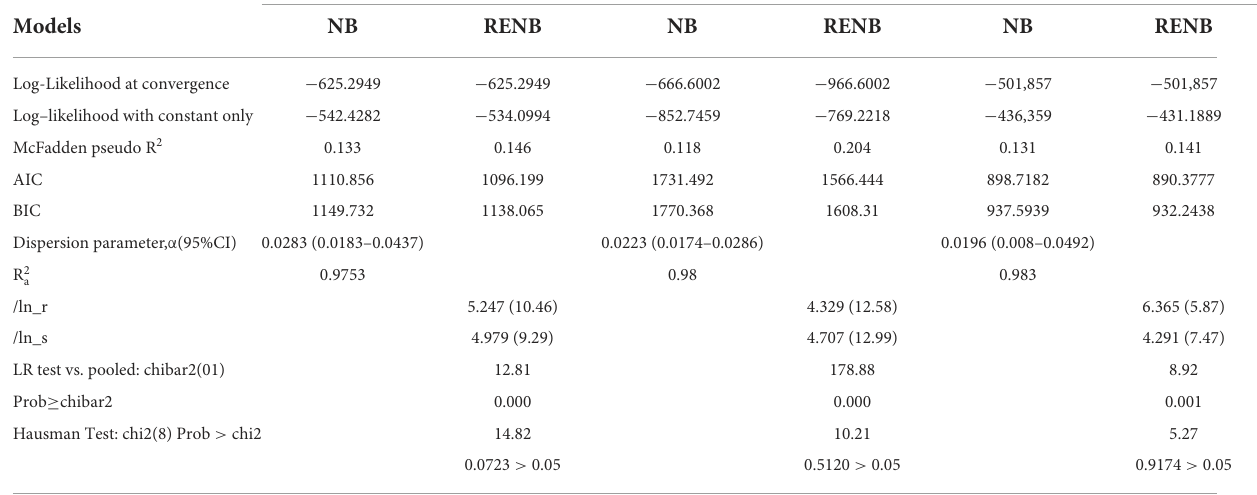
TABLE 3 Results of the fitted